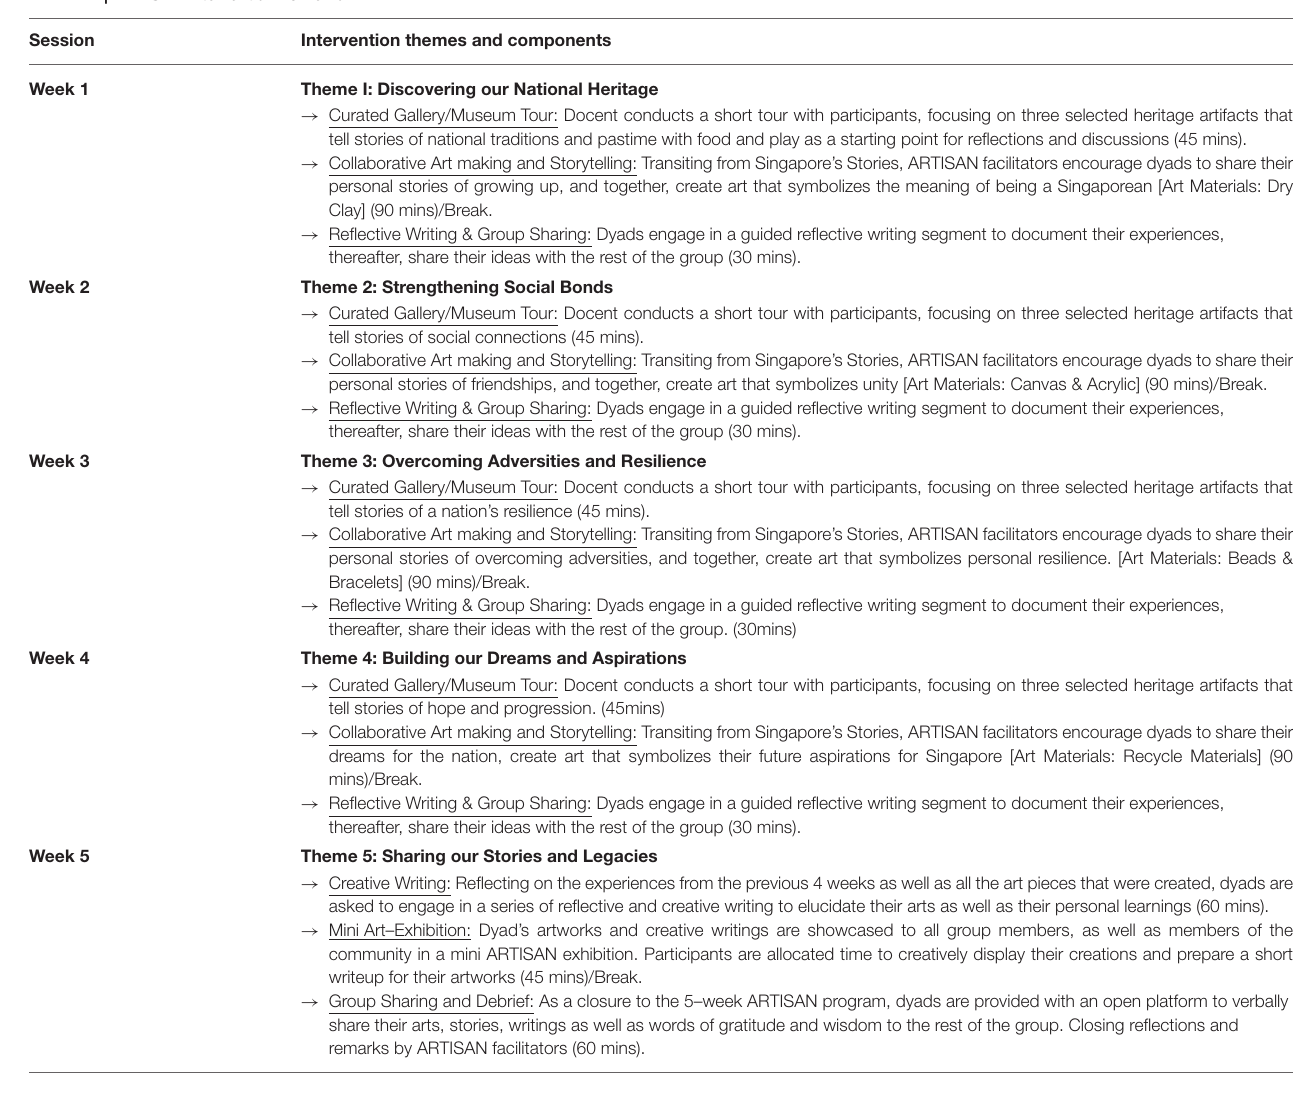
TABLE 1 | ARTISAN intervention